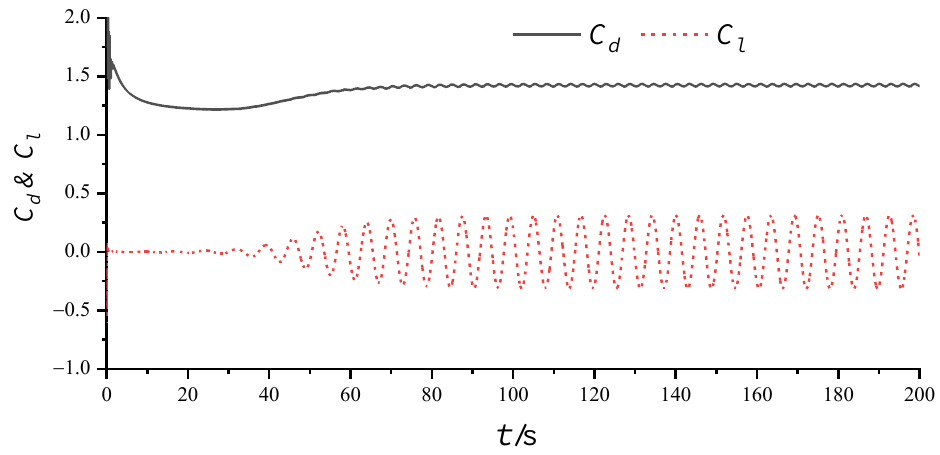
Figure 4. Time history of drag and lift coefficient for Re = 100.